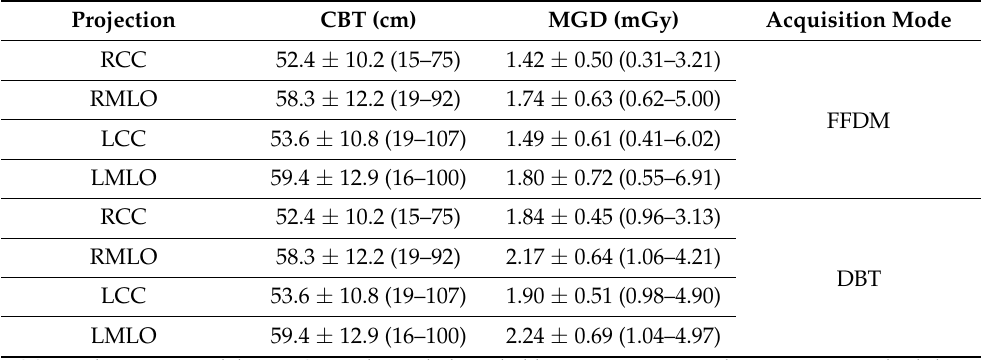
Table 2. Compressed breast thickness (CBT) and mean glandular dose (MGD) per exposure for each projection.